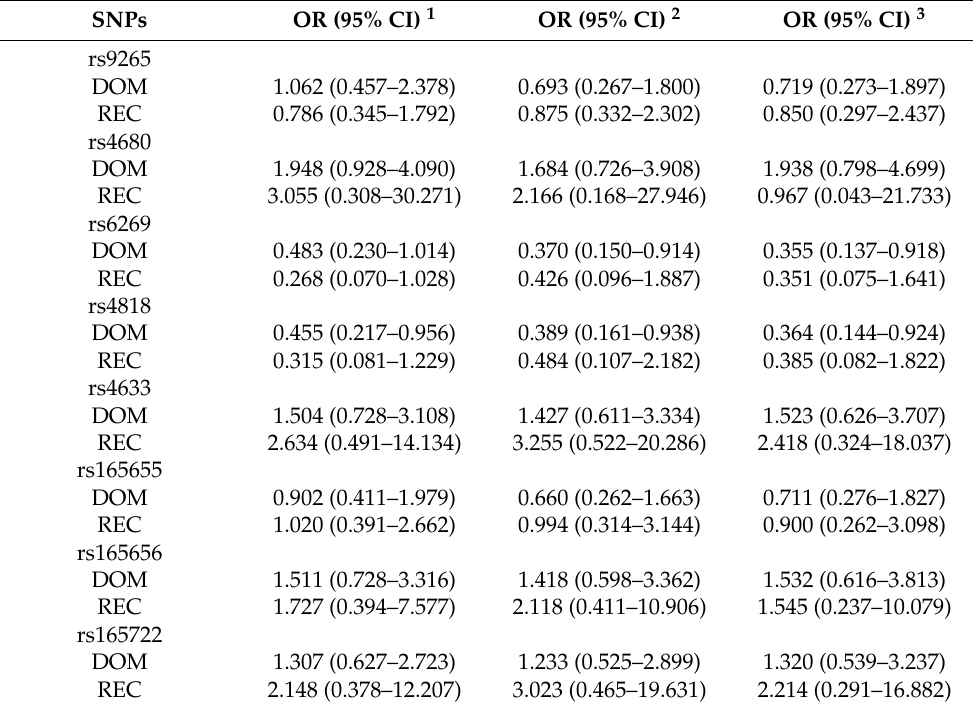
Table 4. Association of the dominant model and recessive model in the PARIs cases and the non-PARI controls.